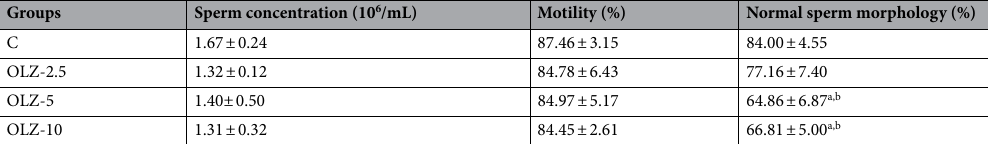
Table 2. Sperm parameters of rats. Definition of abbreviations: OLZ-2.5 2.5 mg kg −1 olanzapine-administered rats for 28 days group, OLZ-5 5 mg kg −1 olanzapine-administered rats for 28 days group, OLZ-10 10 mg kg −1 olanzapine-administered rats for 28 days group. Results were given as mean ± standard error. All data were expressed as mean ± standard error. a Different from control group (p < 0.05). b Different from OLZ-2.5 (p ≤